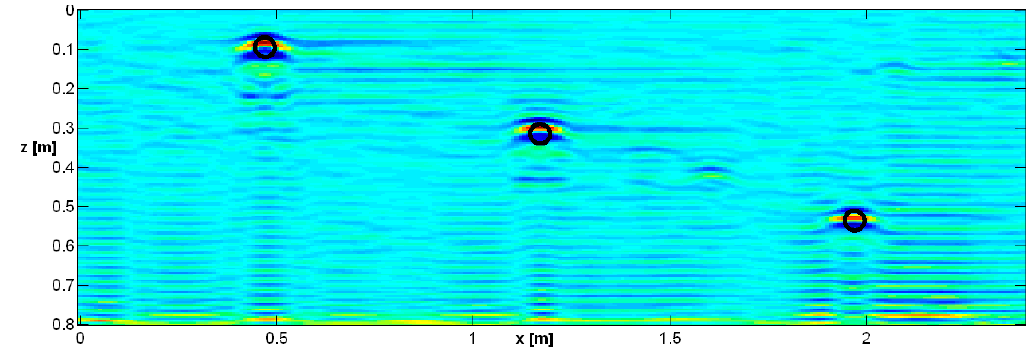
Figure 13. Result of a Kirchhoff migraton performed on the same data as in Figure 10.